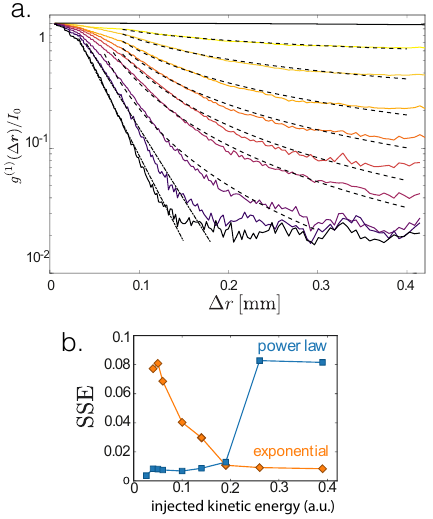
Figure 2. Emergence of an out-of-equilibrium BKT transi- tion in optics. First order correlation function with increasing fluctuation strength ϵ , transition from an algebraic to an ex- ponential order.